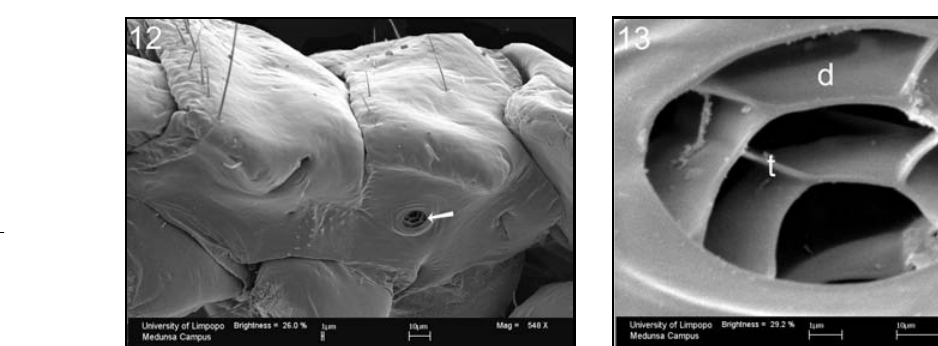
Fig. 13. The spiracular lumen was lined with regular circular disc-shaped (d) structures, intersected by trabecular (t) divisions.